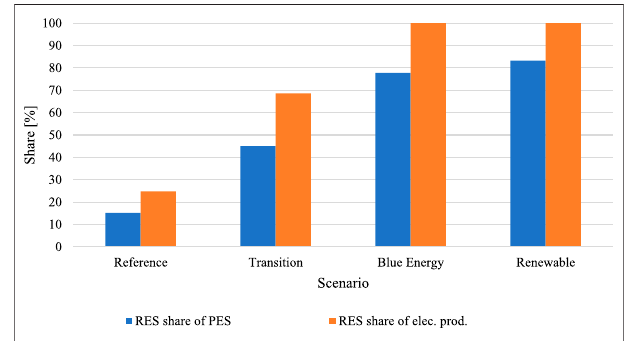
FIGURE 11 | Share of the RES in PES and electricity production.